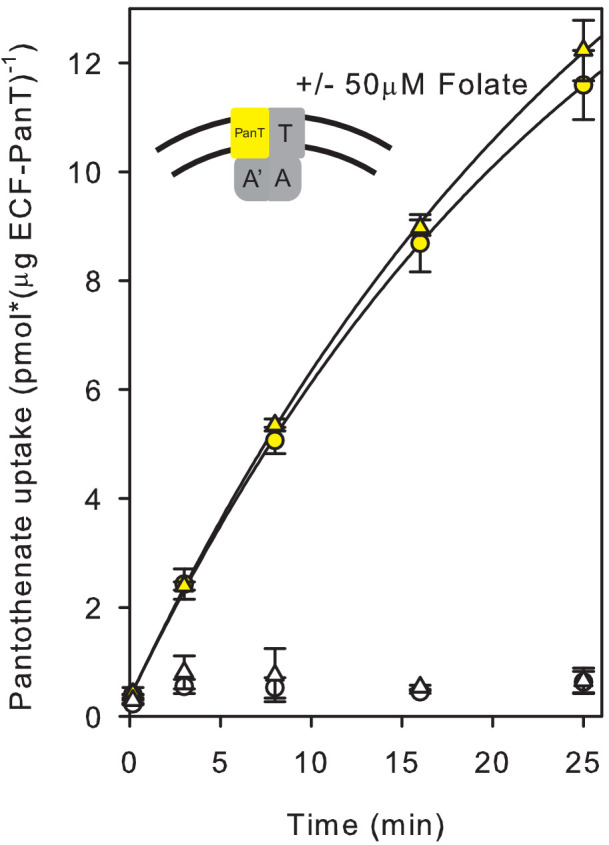
Lack of inhibition of radiolabelled pantothenate uptake by unlabelled folate in proteoliposomes containing only ECF-PanT.Yellow and white circles: Pantothenate uptake by ECF-PanT into proteoliposomes containing 10 mM Mg2+-ATP or Mg2+-ADP in the lumen (as in Figure 1), respectively; yellow and white triangles: same in the presence of unlabelled folate.